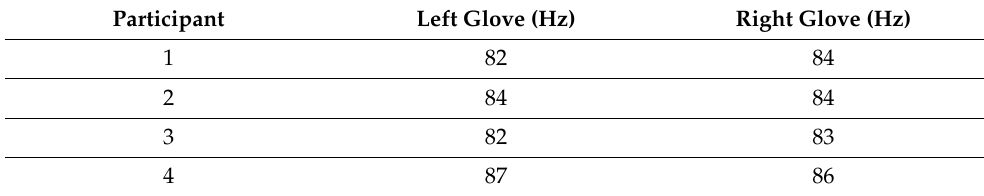
Table 4. Average effective sampling rate of the system.